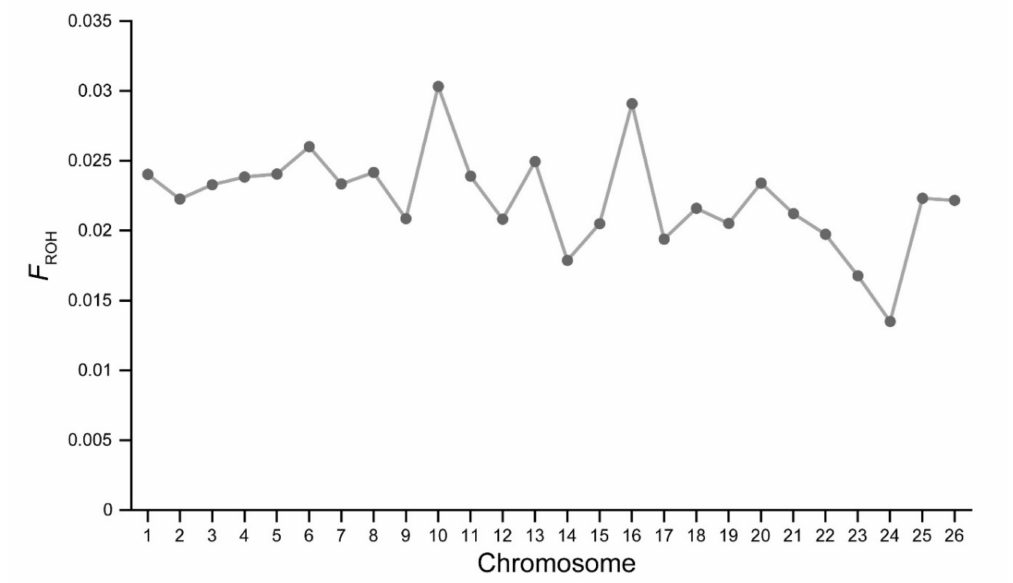
Figure 4. Distribution of ROH-based inbreeding coe ffi cients (F ROHOAR ) on each Ovies aries chromosome (OAR).